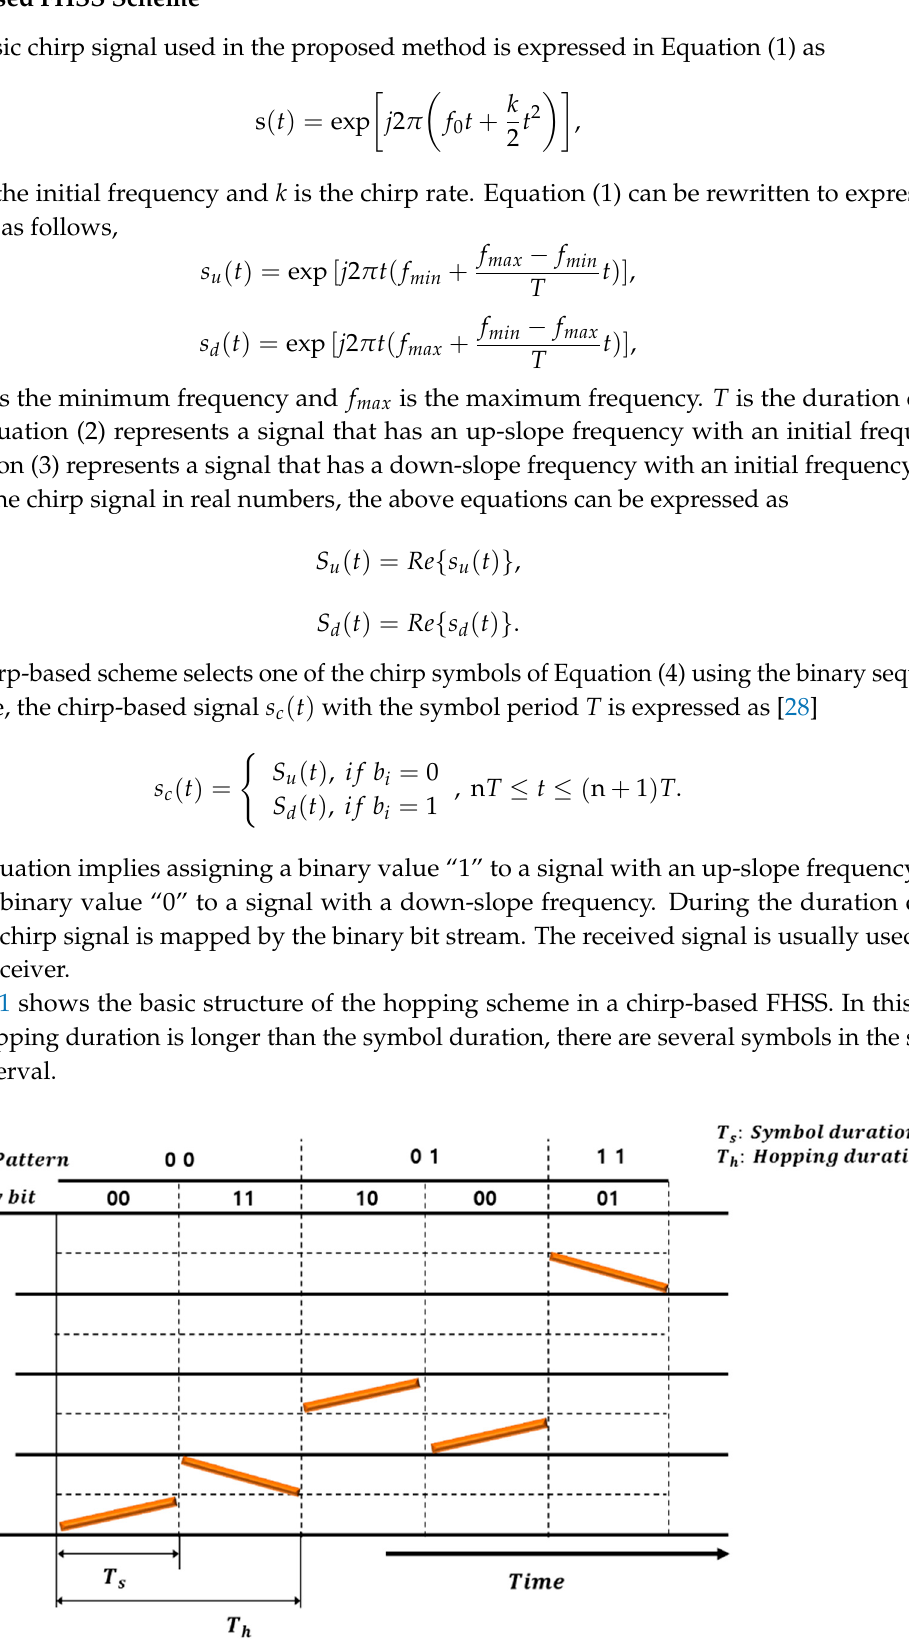
Figure 1. Basic scheme of the chirp-based FHSS.